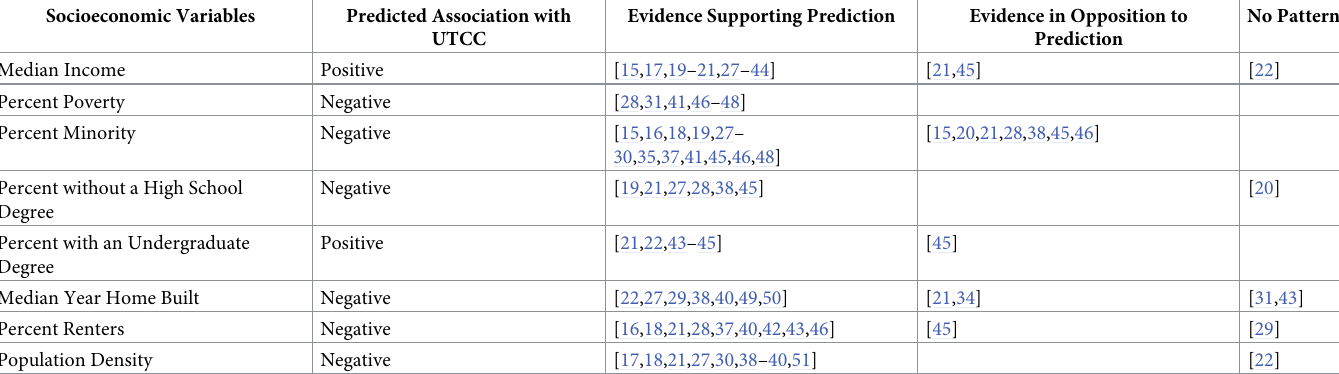
Table 1. Studies examining associations between indicators of urban vegetation presence or abundance and socioeconomic variables. Our predictions are based on the prevailing patterns supported in the literature.